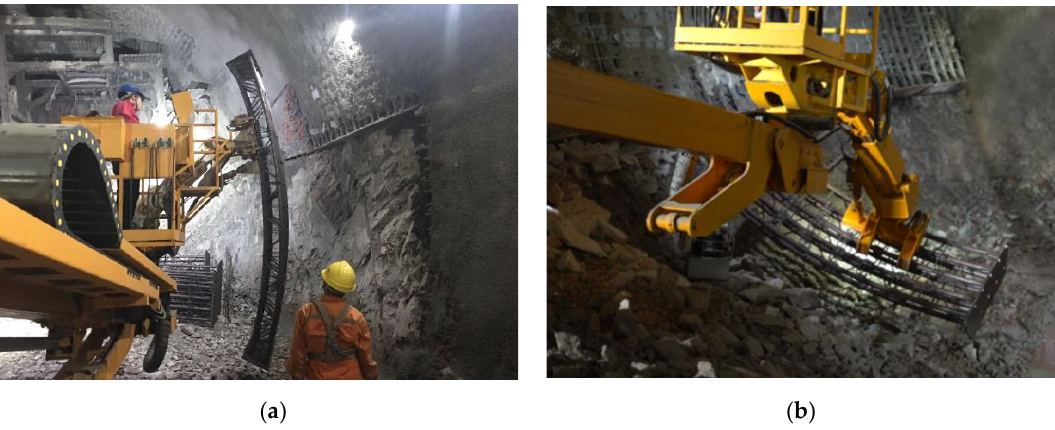
Figure 26. Mechanized installation of arch waist and inverted arch. ( a ) Arch waist and ( b ) inverted arch.